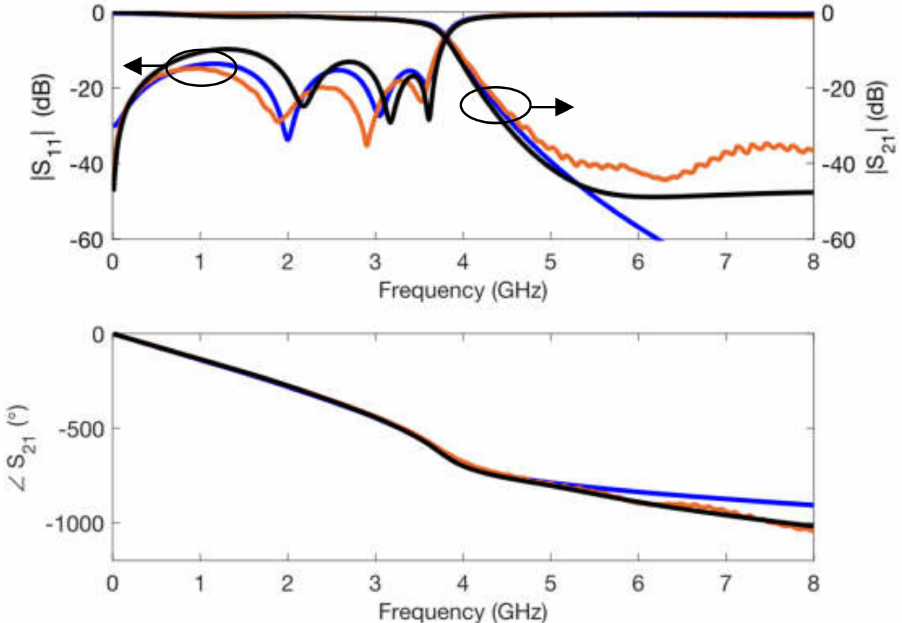
Figure 18. Circuit simulations ( blue ), electromagnetic simulations ( black ) and measurements ( orange ) of the scattering parameters for the low pass filter prototype.